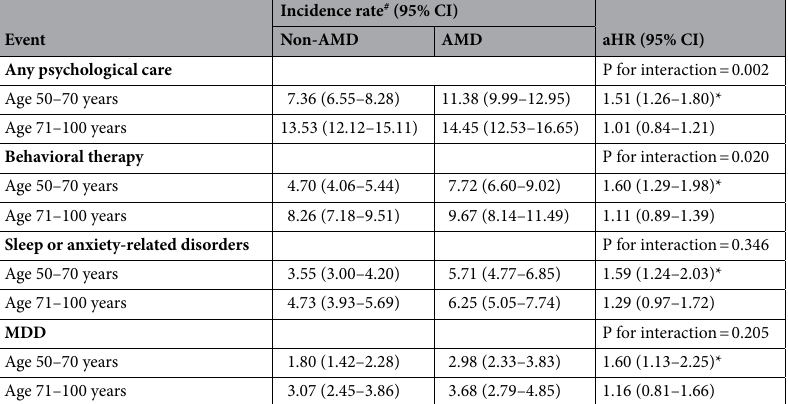
Table 4. Age stratified hazard ratio for mood disorders in patients with AMD compared with individuals without AMD. AMD age-related macular degeneration, aHR adjusted hazard ratio adjusted for age, sex, education, marital status, and comorbidities, CI confidential interval, MDD major depression disorder. *Significant result for null hypothesis of aHR = 1. # Crude incidence rate per 10,000